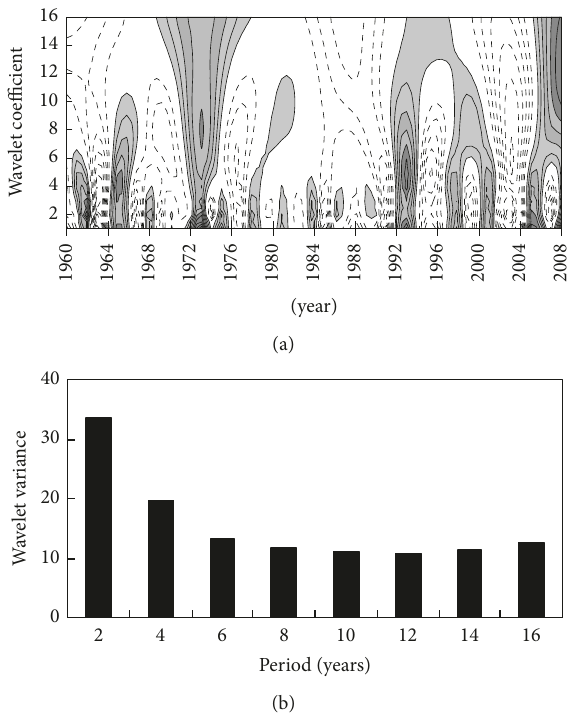
Figure 3: Wavelet transform (a) and wavelet variance (b) of the PSCPRS.